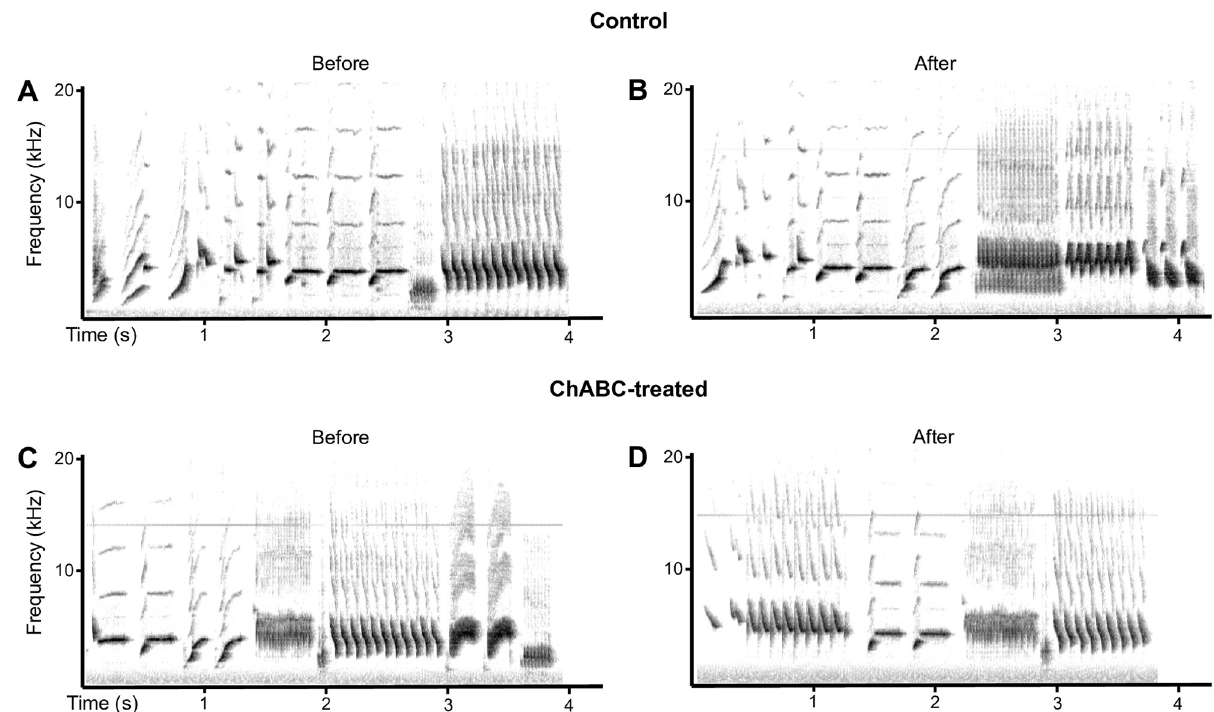
Fig 3. Examples of sonograms of songs collected before and after surgeries in the Ctrl and ChABC-treated males.